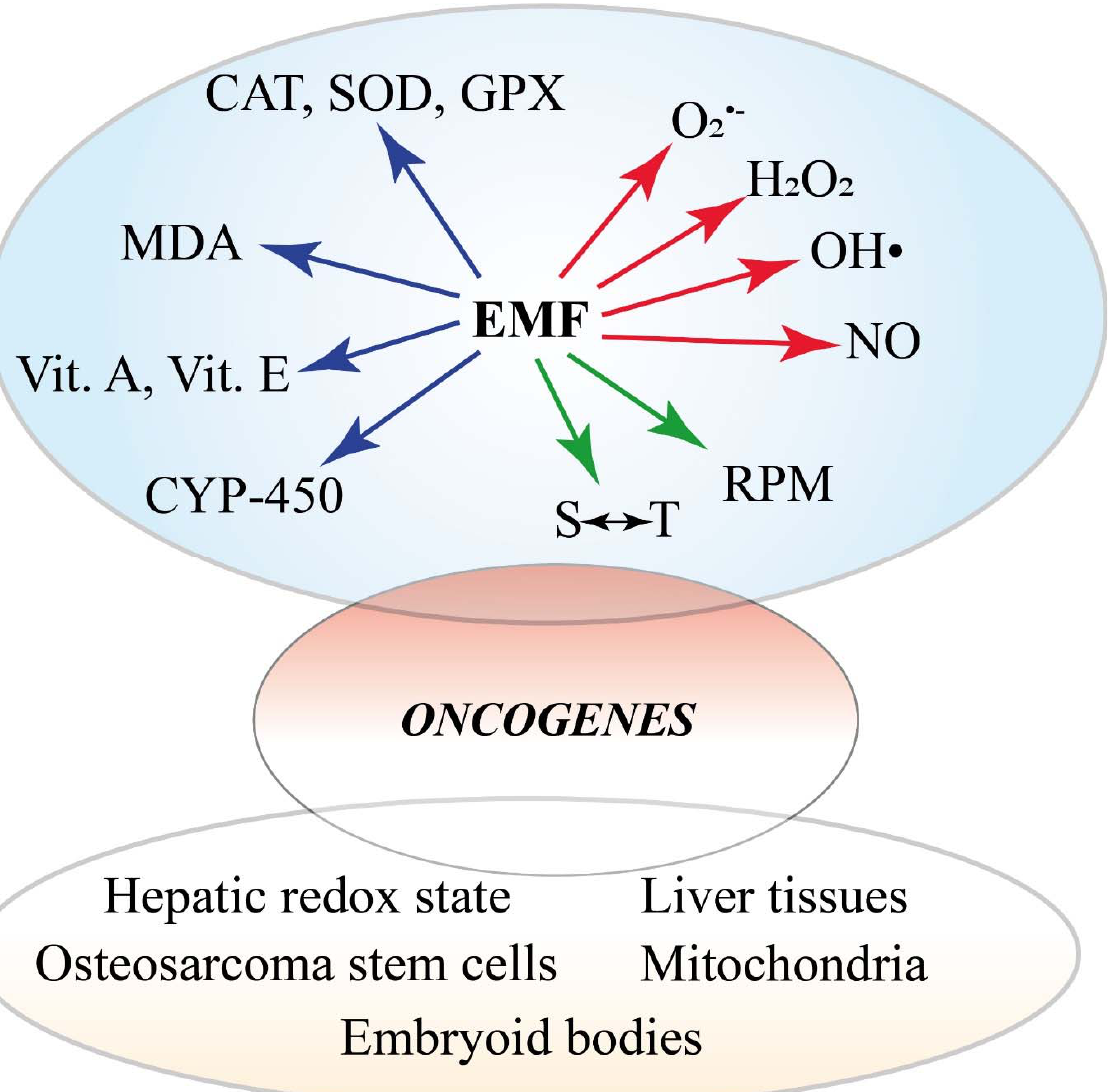
Figure 5. Summary of the involvement of ROS and RNS in the cellular and organismic responses to MFs. There are three major effects of varying MF the are reported. MFs alter the redox status of the cell by affecting the activity and gene expression of ROS ‐ scavenging systems, including CAT, SOD, GPX, vitamins, and monooxygenases. Membrane degradation is evidenced by MDA detection. On the other hand, MFs trigger the production of ROS and NOS and early events involving the radical pair mechanism and spin ‐ chemical effects. The altered oxidative status eventually induces the ex ‐ pression of oncogenes. The alteration of the oxidative status is also evident at the subcellular, cellu ‐ lar, tissue, and organ level.